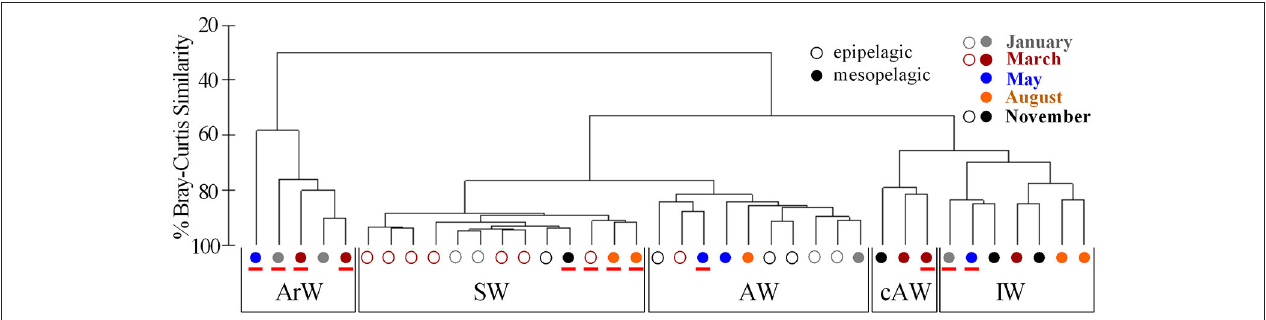
FIGURE 3 | Hierarchical cluster analysis of Bray-Curtis similarities, based on the diversity of Thaumarchaeota sequences from Illumina amplicon sequencing of 16S rRNA genes, illustrating the distribution of samples into five groups. These five groups are labeled according to water mass specificities of the samples within the groups (ArW, Arctic Water; SW, Surface Water; AW, Atlantic Water; cAW, cold Atlantic Water; IW, Intermediate Water). Samples with a mismatch between their associated water mass group and the physical water mass of their sampling origin are marked with a red line. The sampling month is given by colors. Samples were further distinguished according to depth, with open circles for epipelagic samples (0–200m; n = 16) and filled circles for mesopelagic samples (200–1,000m; n = 22).